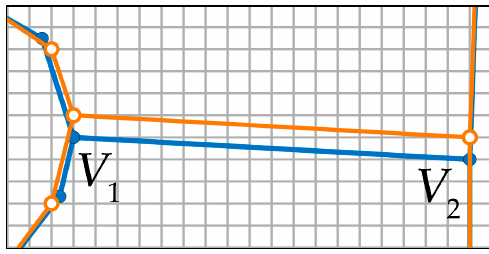
Figure 17. Simplified results of different algorithms: ( a ) improved Opheim; ( b ) DP; ( c ) VW, and ( d ) Opheim algorithms.